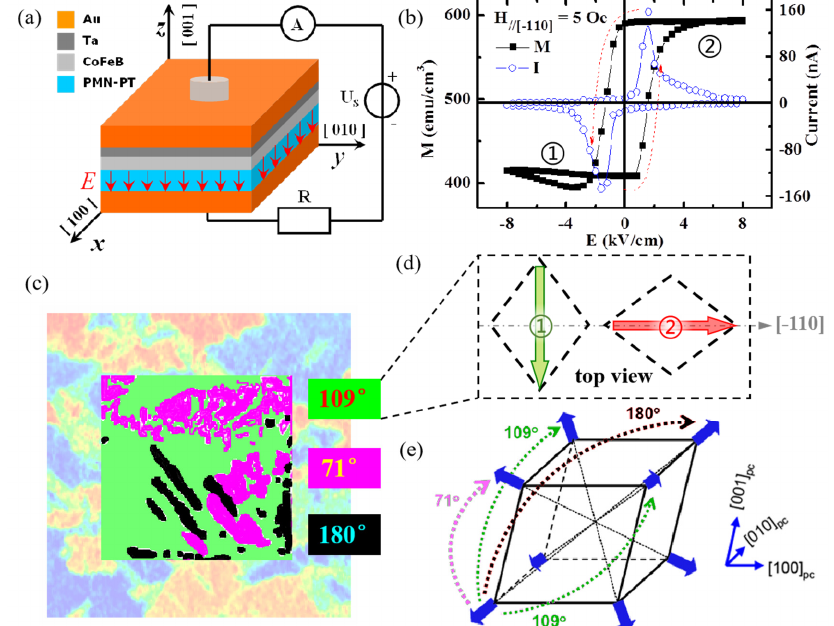
Figure 5. The nonvolatile and reversible electric-field control of magnetization in the CFB/PMN–PT (001) heterostructure. ( a ) Scheme of the sample and experiment configuration. ( b ) Electric-field control of the magnetization (solid square) and polarization current (open circle) recorded simultaneously, in which magnetization of state 1 and 2, respectively, corresponds to the lattice deformation of state 1 and 2 in ( d ). ( c ) Three types of FE domain switching, namely 71 ◦ (purple), 109 ◦ (green), and 180 ◦ (black) in the (001)-cut PMN–PT single crystal, measured by piezoresponse force microscopy. ( d ) Top view of the rhombohedral lattice deformation in the 109 ◦ domain switching. ( e ) The corresponding changes of the FE polarization direction for the three types of FE domain switching in each rhombohedral lattice. Reproduced with permission from reference